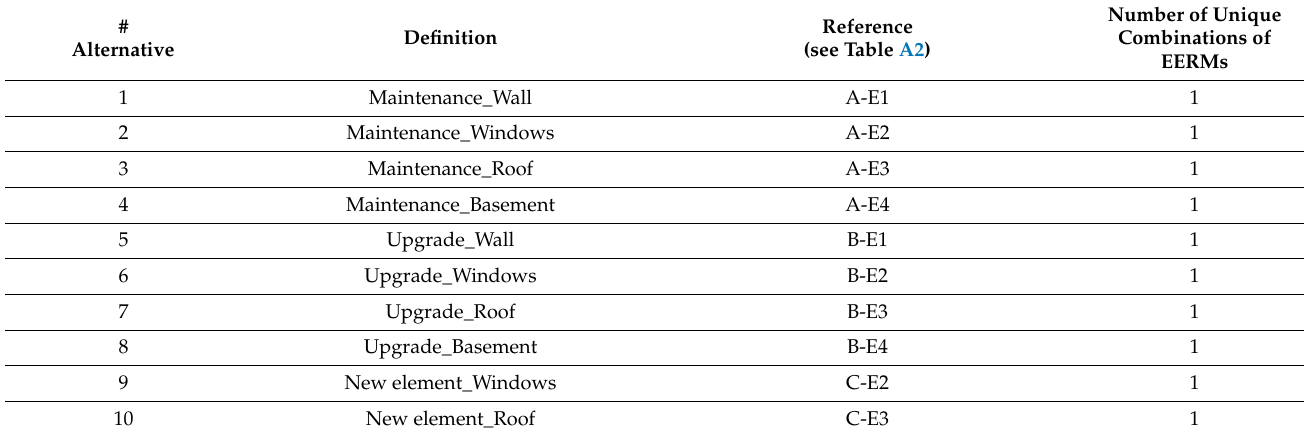
Table A3. Building interventions (BIs) used as discrete alternatives in the model